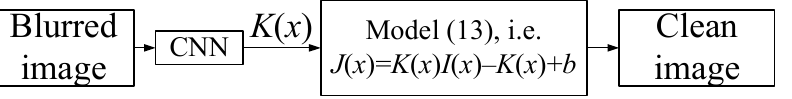
Figure 5. Dehazing of underwater images using all-in-one model.